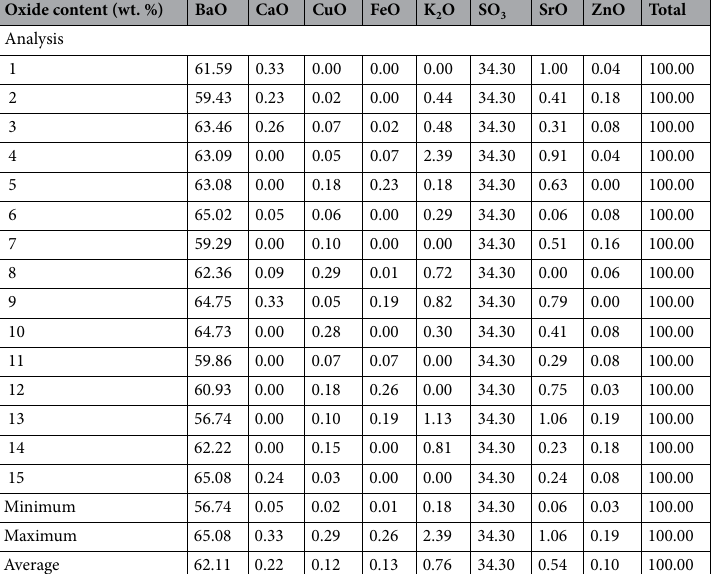
Oxide content (wt.